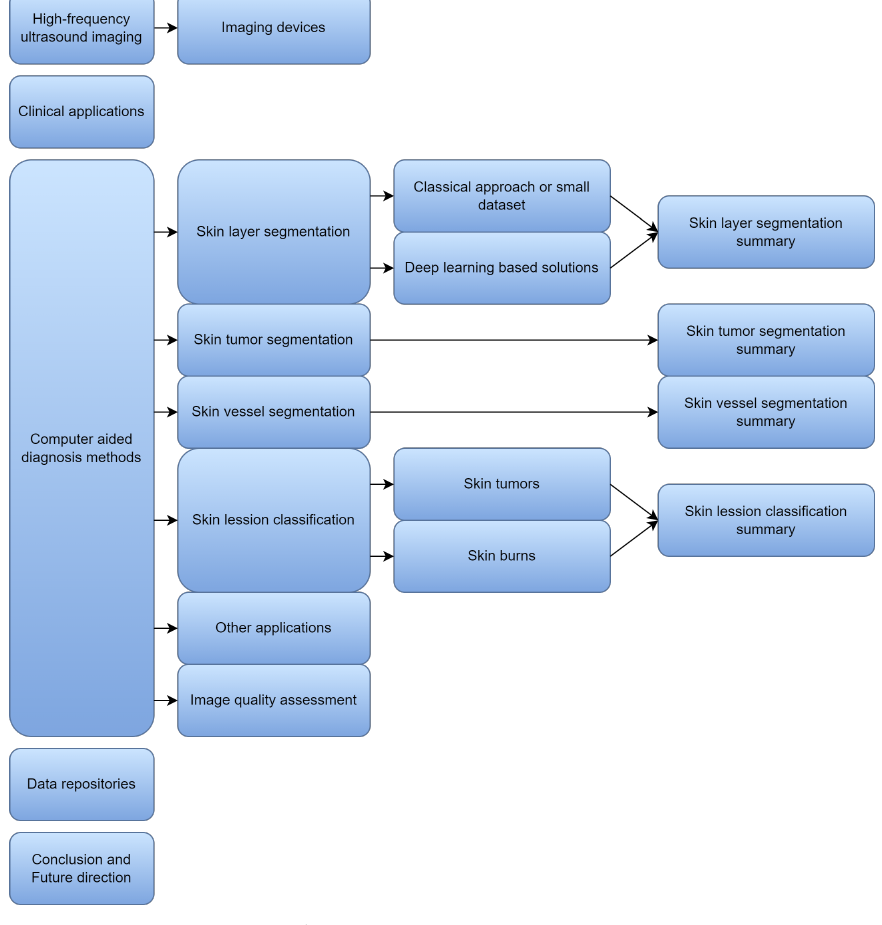
Figure 2. Review’s structure